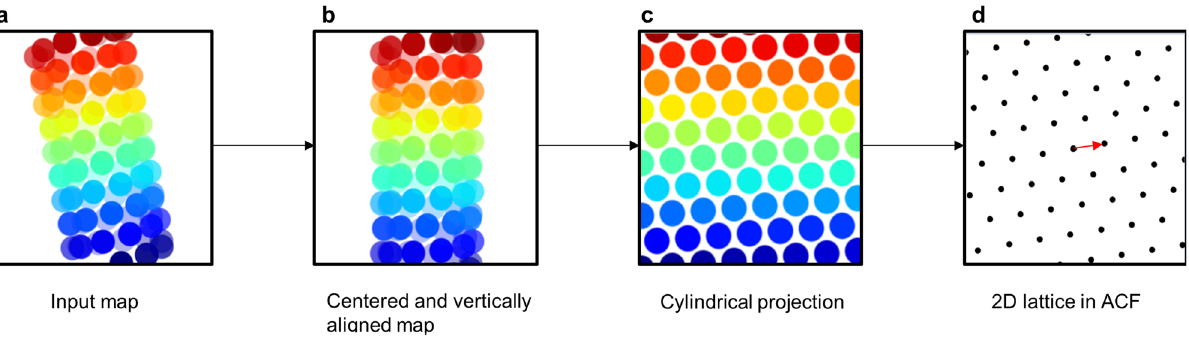
Figure 1. HI3D workflow. The input asymmetric density map ( a ) that is arbitrarily positioned and orientated is automatically centered and vertically aligned ( b ). The aligned 3D map is resampled in the cylindrical coordinate to generate the cylindrical projection ( c ) to mathematically convert a helical structure in the original 3D map into a “2D crystal” image. The auto-correlation function of the cylindrical projection would generate a 2D lattice ( d ) that visually resembles the diffraction spots of a crystal. The unit cell vector (red arrow in d) with the shortest distance to the equator would correspond to the helical twist (x-coordinate) and rise